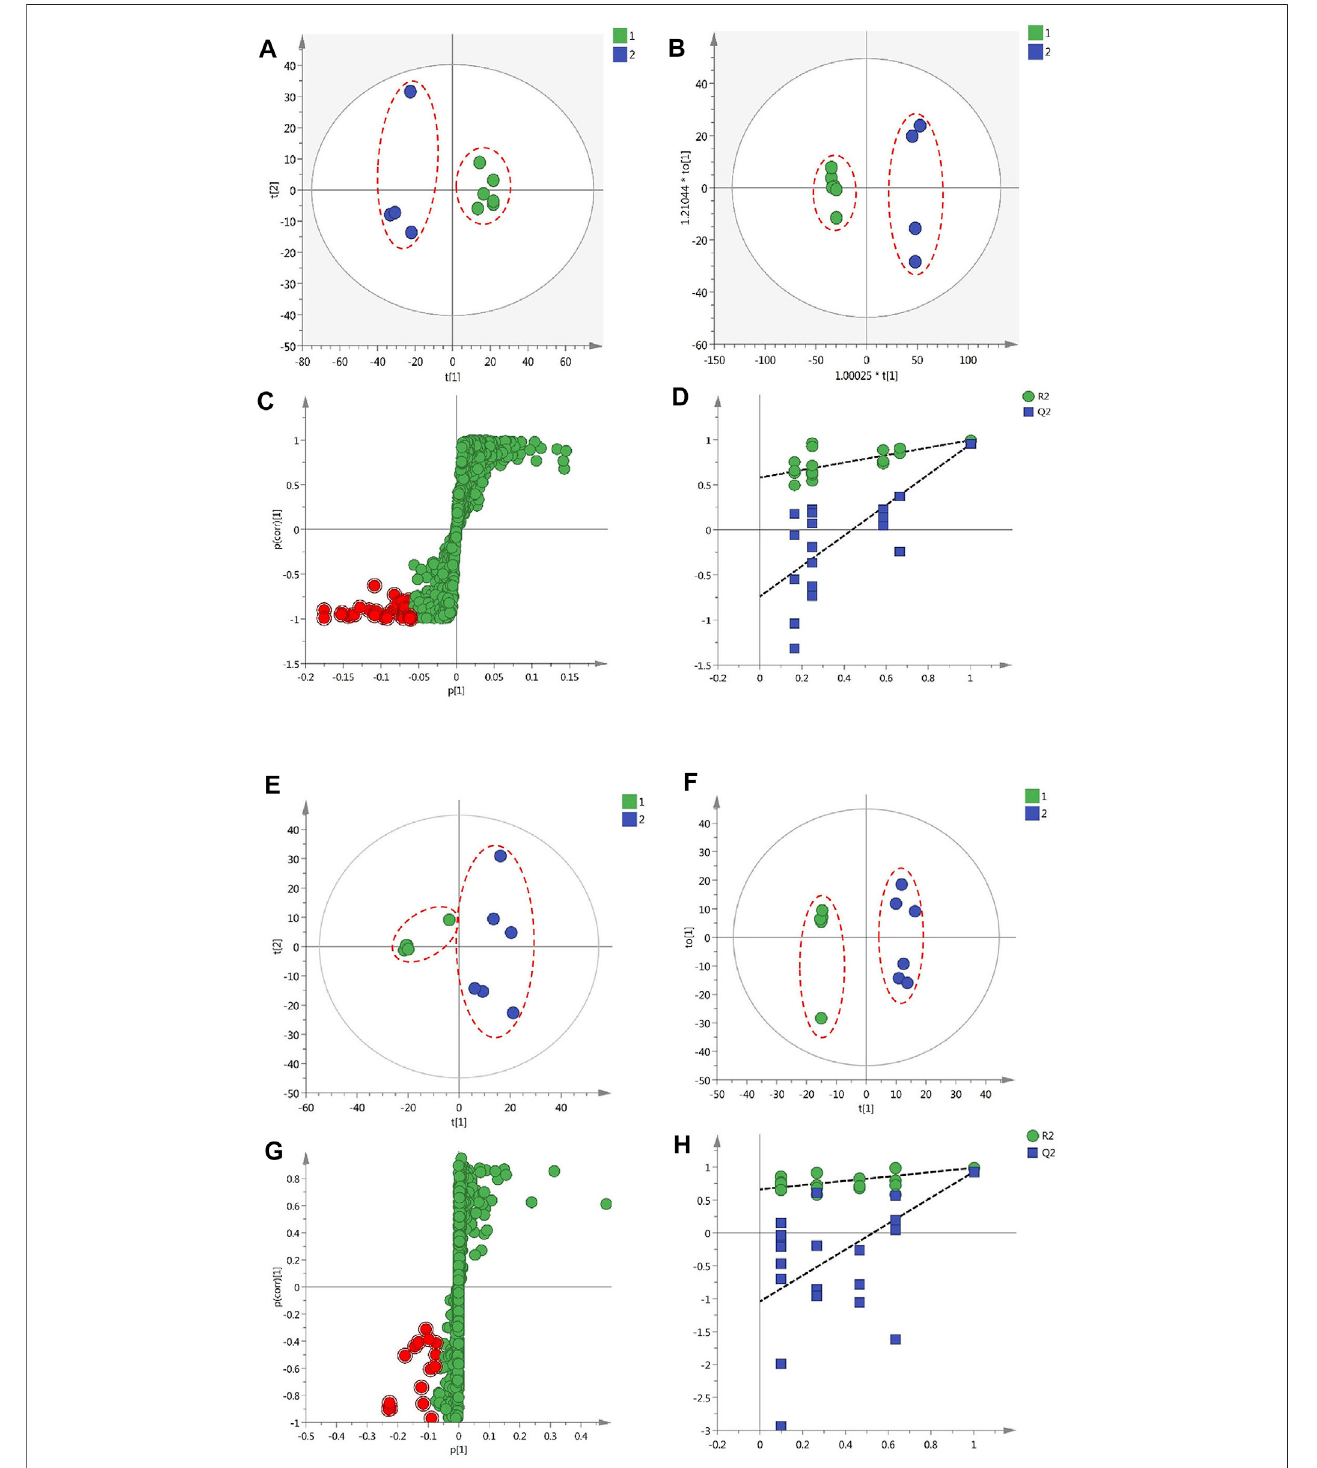
FIGURE 4 | The results of multivariate statistical analysis of metabolomic data of protective effects of GF on liver injury and in fl ammation (A) A PCA scatter plot of 10 GFsamples (B) TheOPLA-DAscatterplotofthe10samples (C) TheS-plotsfortheOPLA-DAintheexperimentsofliverprotection (D) PTtestoftheOPLA-DAmodel in experiments of liver protection (E) The PCA scatter plot of 11 GF samples (F) The OPLA-DA scatter plot of 11 samples (G) S-plots for the OPLA-DA in anti- in fl ammatory experiments (H) PT test of the OPLA-DA model in anti-in fl ammatory experiments.